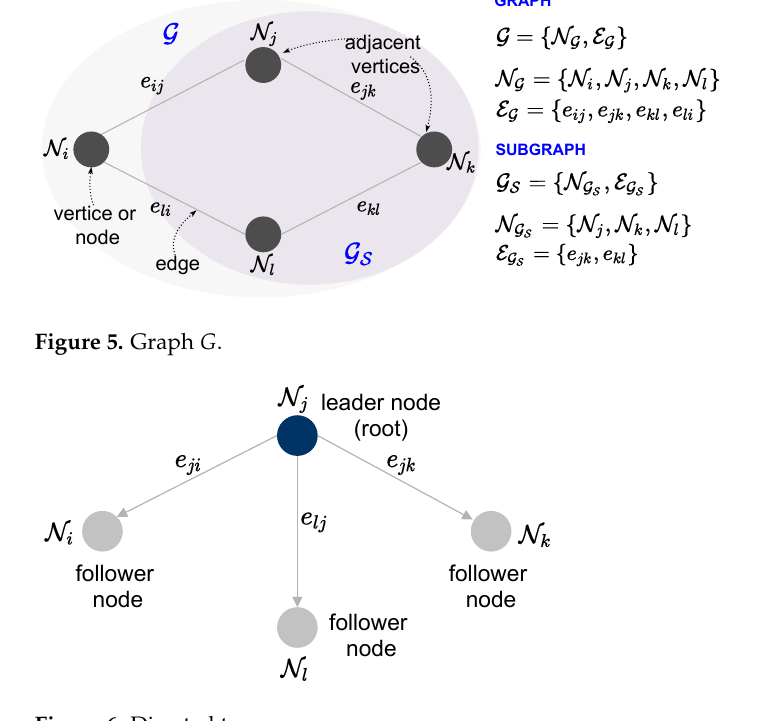
Figure 6. Directed